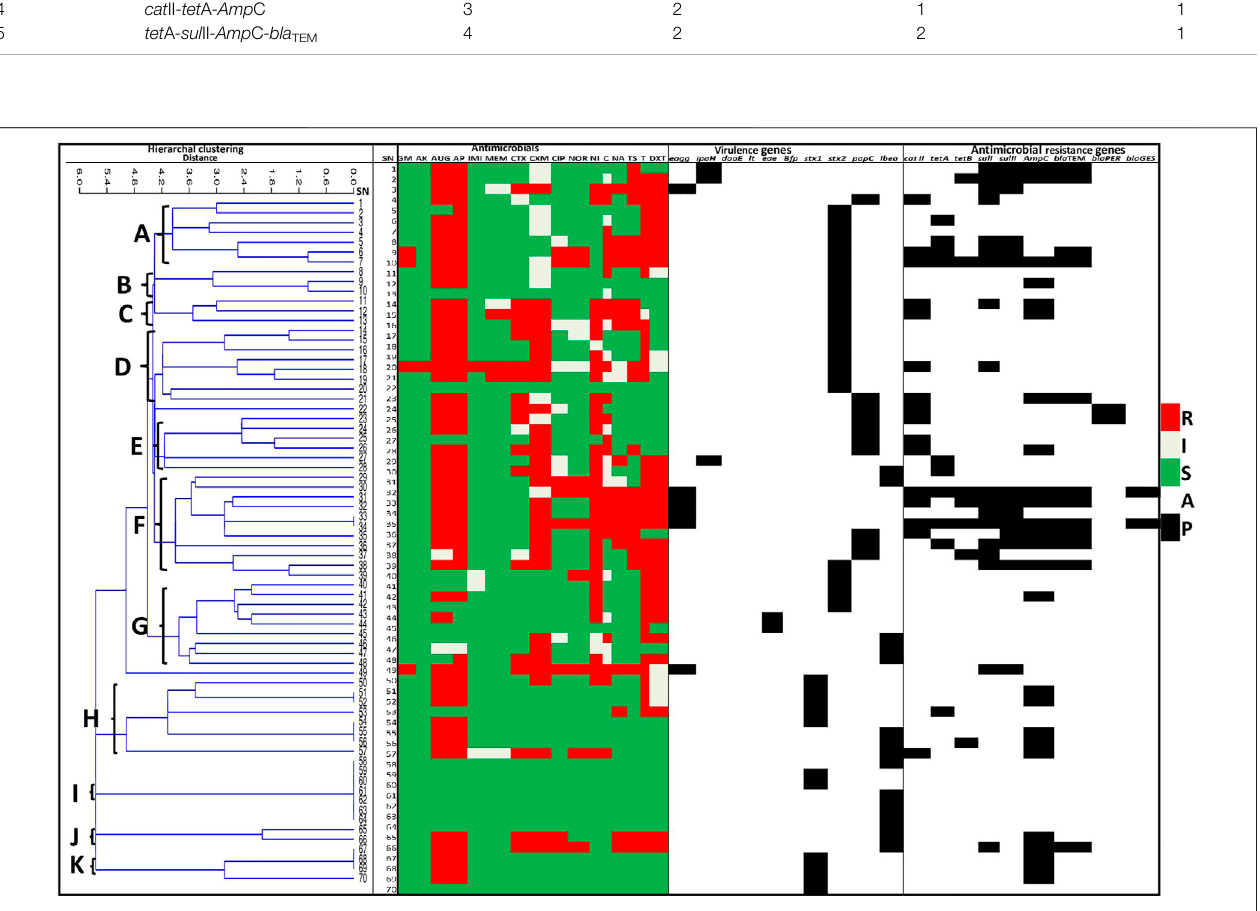
FIGURE 6 | A heatmap cluster analysis of the antibiogram pro fi les of the pathogenic strains of E. coli retrieved from irrigation water samples. The clusters grouped related isolates into clades A to K based on their response/activity to the test antimicrobials. SN: Isolate numbers, R: Resistance, I: Intermediate, S: Susceptible, A: Absent, P: Present, GM-gentamycin, AK-amikacin, AUG-amoxycillin clavulanic acid, AP-ampicillin, IMI-imipenem, MEM-meropenem, CTX-cefotaxime, CXM- cefuroxime, CIP-cipro fl oxacin, NOR-nor fl oxacin, NI-nitrofurantoin, C-chloramphenicol, NA-nalidixic acid, TS-trimethoprim/sulphamethoxazole, T-tetracycline,